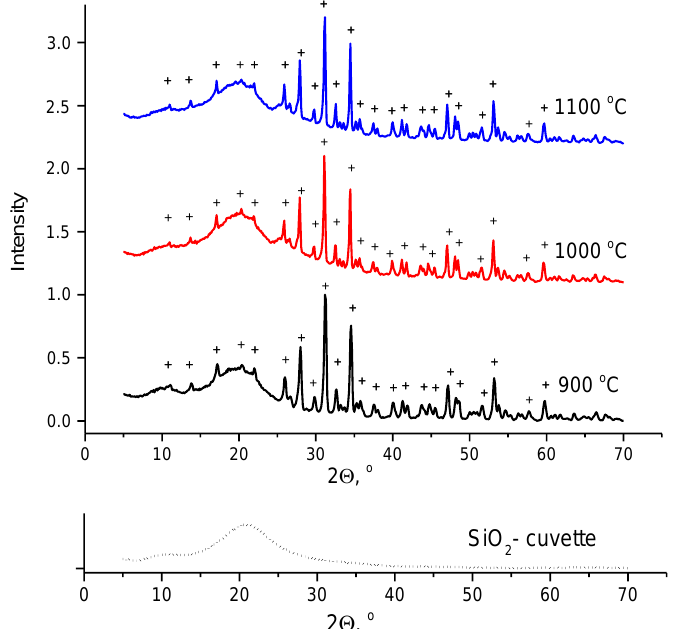
Figure 7. XRD data for ceramic samples fired at different temperatures with 2 h holding time; (+)— β -tricalcium phosphate (PDF card